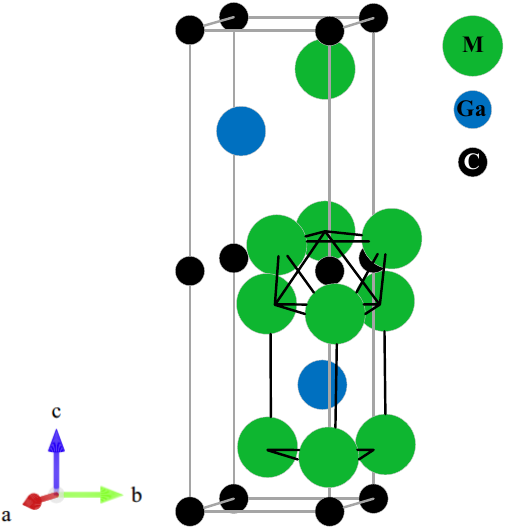
Figure 1. The unit cell of the M 2 GaC MAX phase (M = Zr, Hf). An edge shared [M 6 X] octahedra and a [M 6 A] trigonal prism are